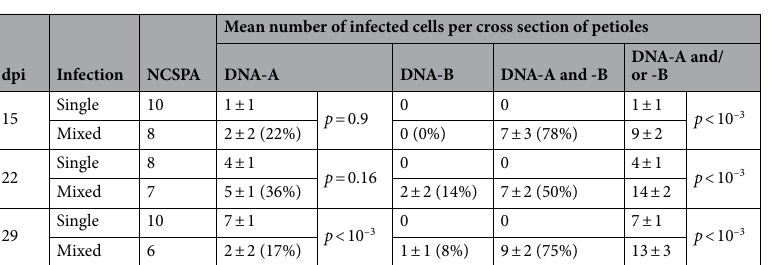
Table 4. Number of infected cells per cross section of tomato petioles infected by PepYVMLV DNA-A in single or mixed infection with DNA-B. DNA-A and -B components were detected respectively using red- and green-FISH probes. Values in brackets show the percentage of infected cells per detected component (DNA-A or -B) or components (DNA-A and -B). dpi days post inoculation, NCSPA number of cross sections of petioles analysed. p values were obtained from multiple comparisons of means of cell numbers between single and mixed infection cases using post-ANOVA Tukey HSD-test.